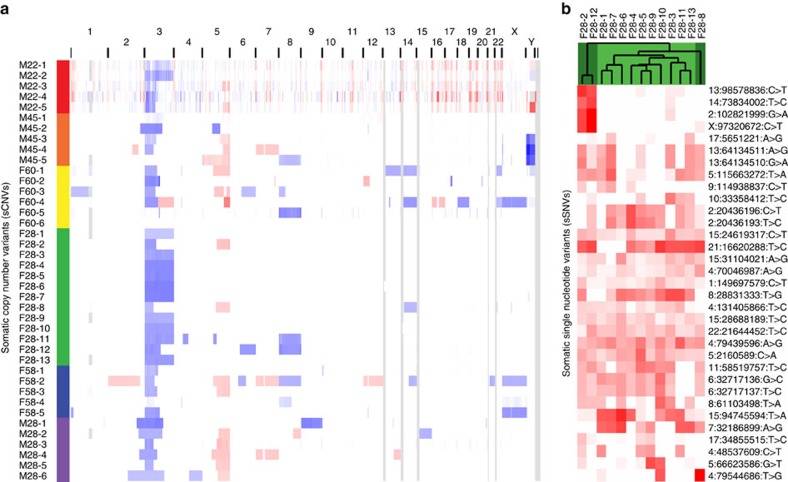
Copy number variants confirmed that the tumours are independent but showed within-patient patterns.(a) Copy number results: red bars indicate gains and blue bars indicate losses. The germline genetic background or environment in patient F28green predisposed her tumours to lose a complete copy of chromosome 3 over the more common loss of only 3p. Given that <10% of The Cancer Genome Atlas ccRCC tumours exhibited complete loss of chromosome 3, the likelihood of at least 10 out of 13 of patient F28green's tumours losing all of chromosome 3 by chance is 0.000000021 (binomial distribution). (b) Somatic SNVs in patient F28green: SNVs that were called in at least two tumours from patient F28green and had sufficient coverage in all tumours are shown. No single-nucleotide variants were called in the 10 tumours with chr3 loss (light green) and not in the 3 tumours with chr3p loss (dark green), which supports the hypothesis that either the loss occurred 10 independent times or the loss occurred very early in a founding cell.